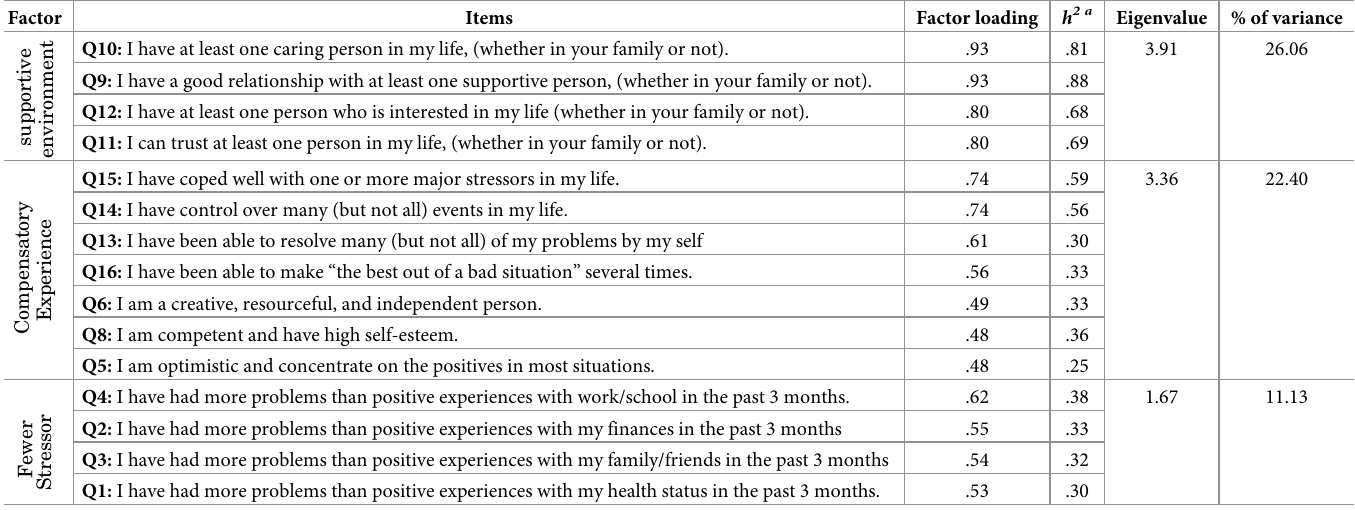
Table 2. Exploratory factor analysis of the Persian version of the